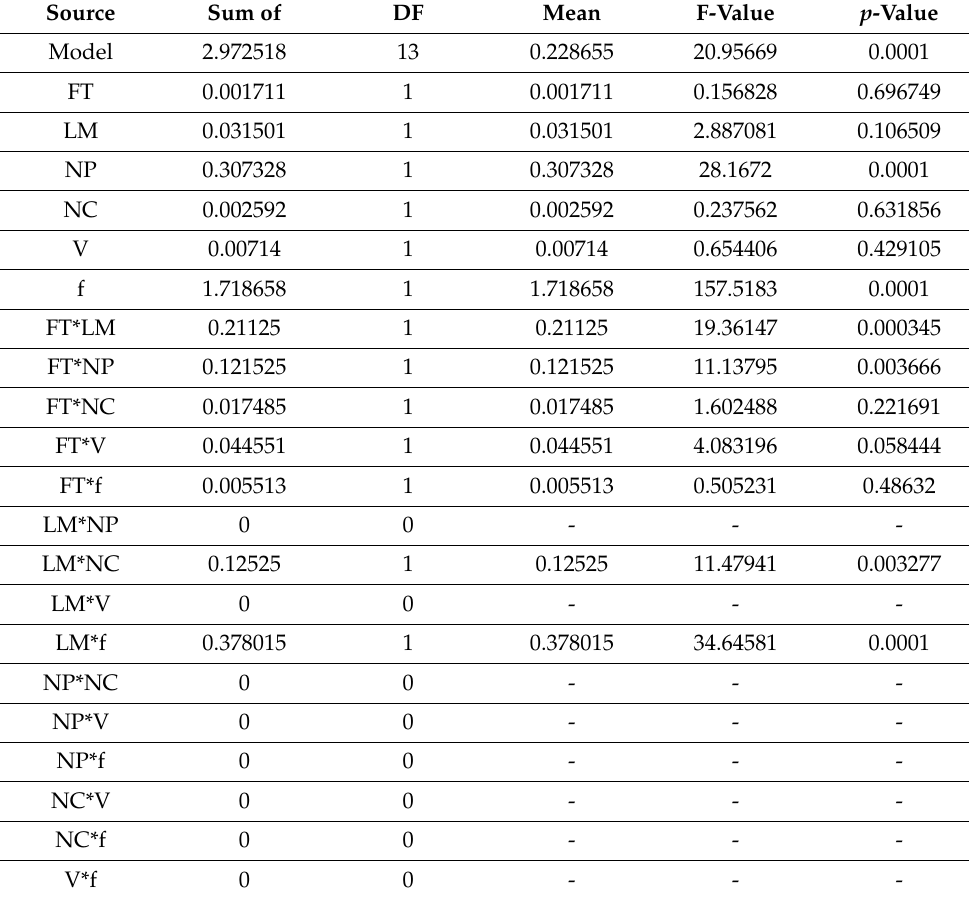
Table 6. Results of ANOVA analysis for surface